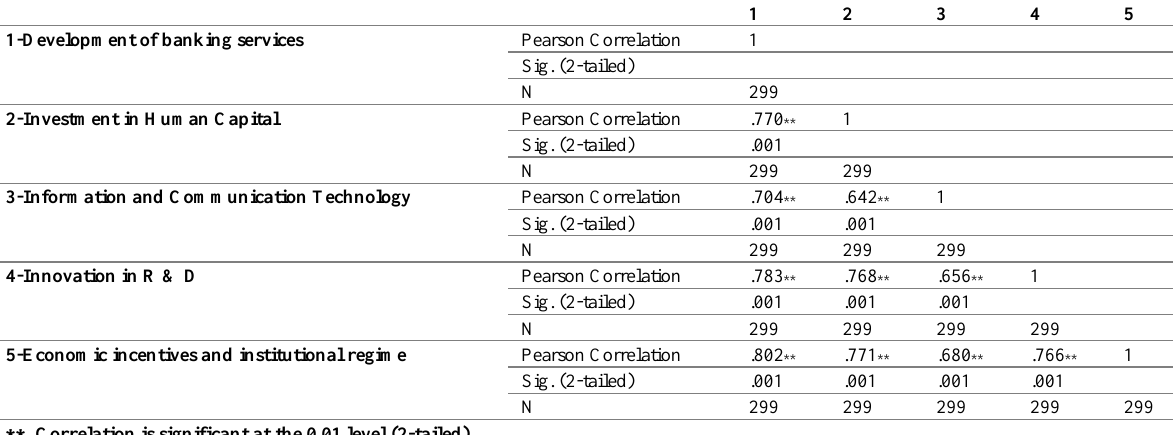
Table 7: Correlations Between Main Variables of Knowledge Economy and The Development of Banking Services